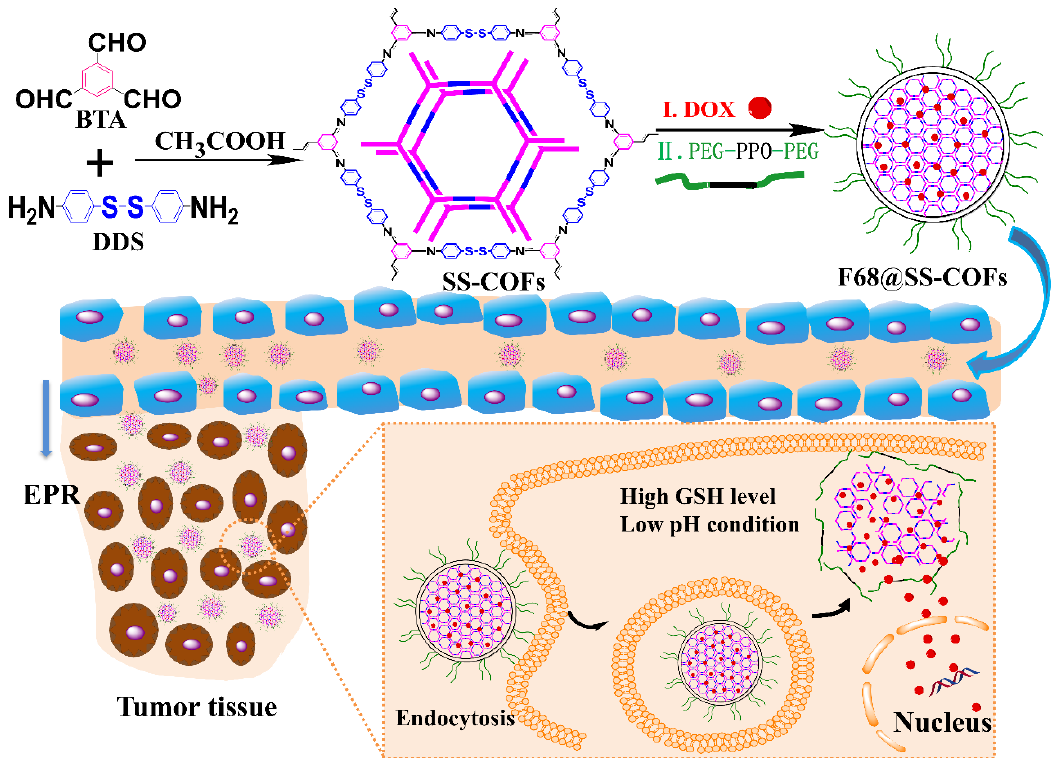
Figure 8. Schematic representation of the preparation and intracellular GSH-responsive drug release of DOX-loaded F68@SS-COFs [106]. Reprinted with permission from ref. [106]. Copyright 2020 John Wiley and Sons.